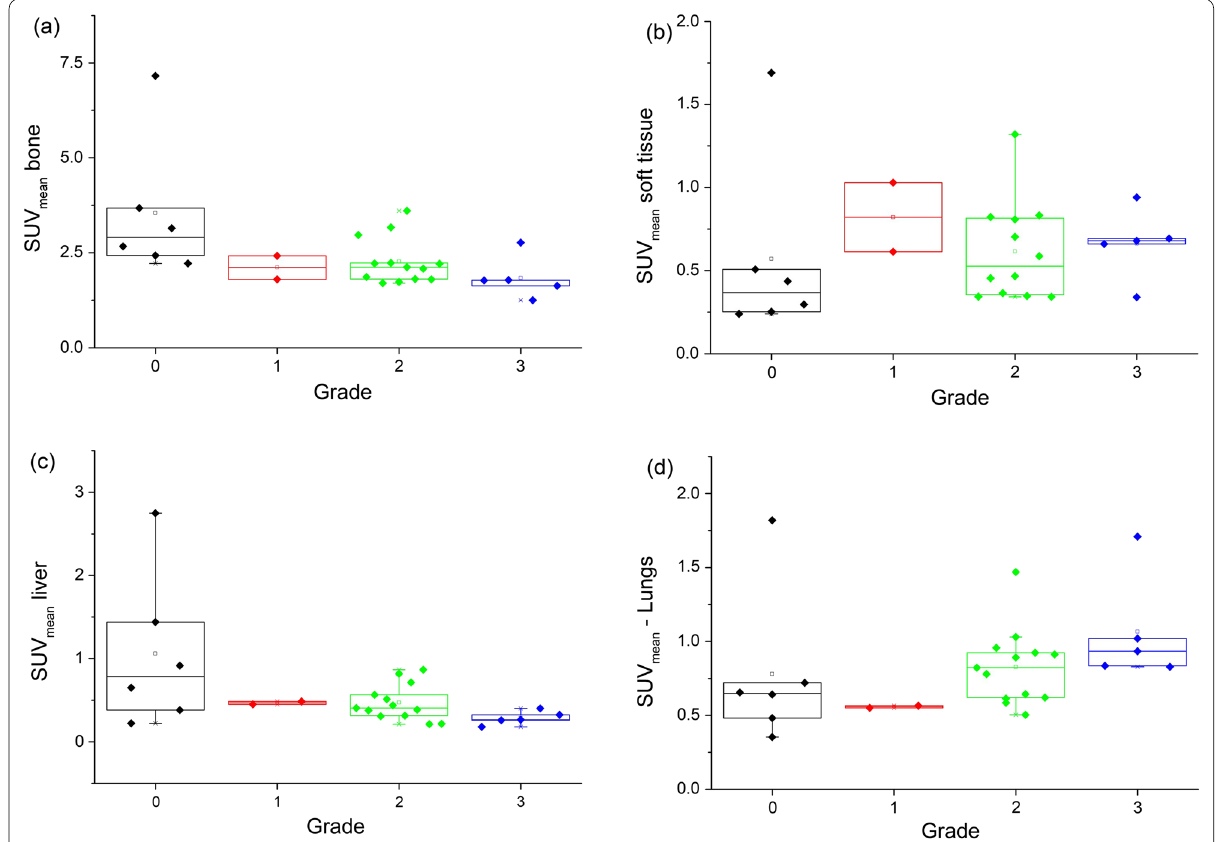
Fig. 3 Bar graph showing separation of SUVmean of a bone, b soft tissue, c liver, d lungs by visual cardiac uptake grade. SUV, standardized uptake value